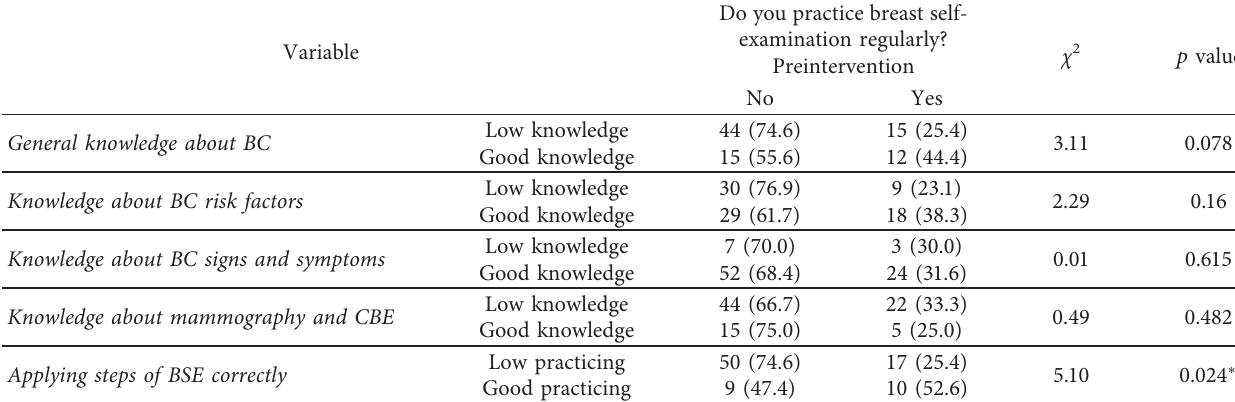
Table 5: Relationship between knowledge about BC and related items and regular practice of